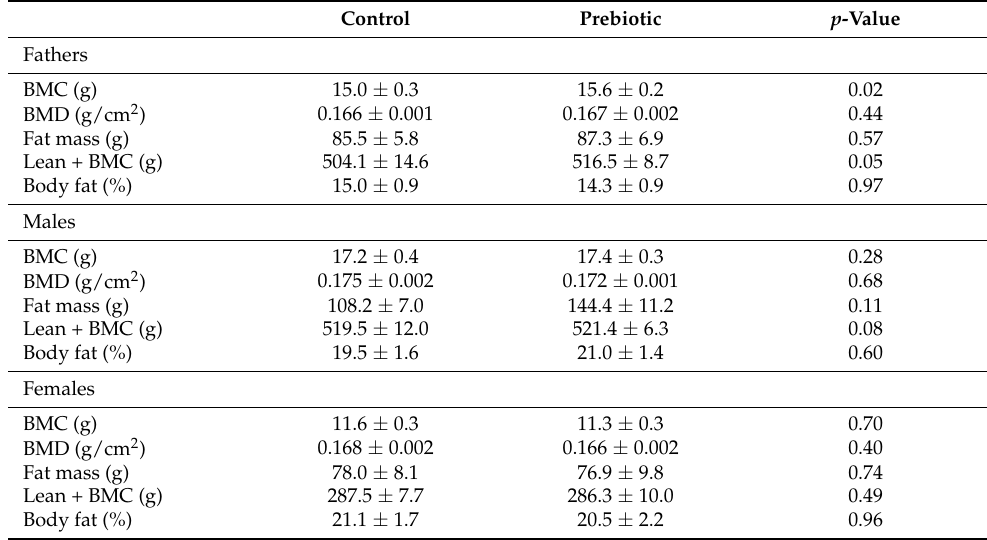
Table 2. Body composition of fathers at 12 weeks of age and offspring at 16 weeks of age 1